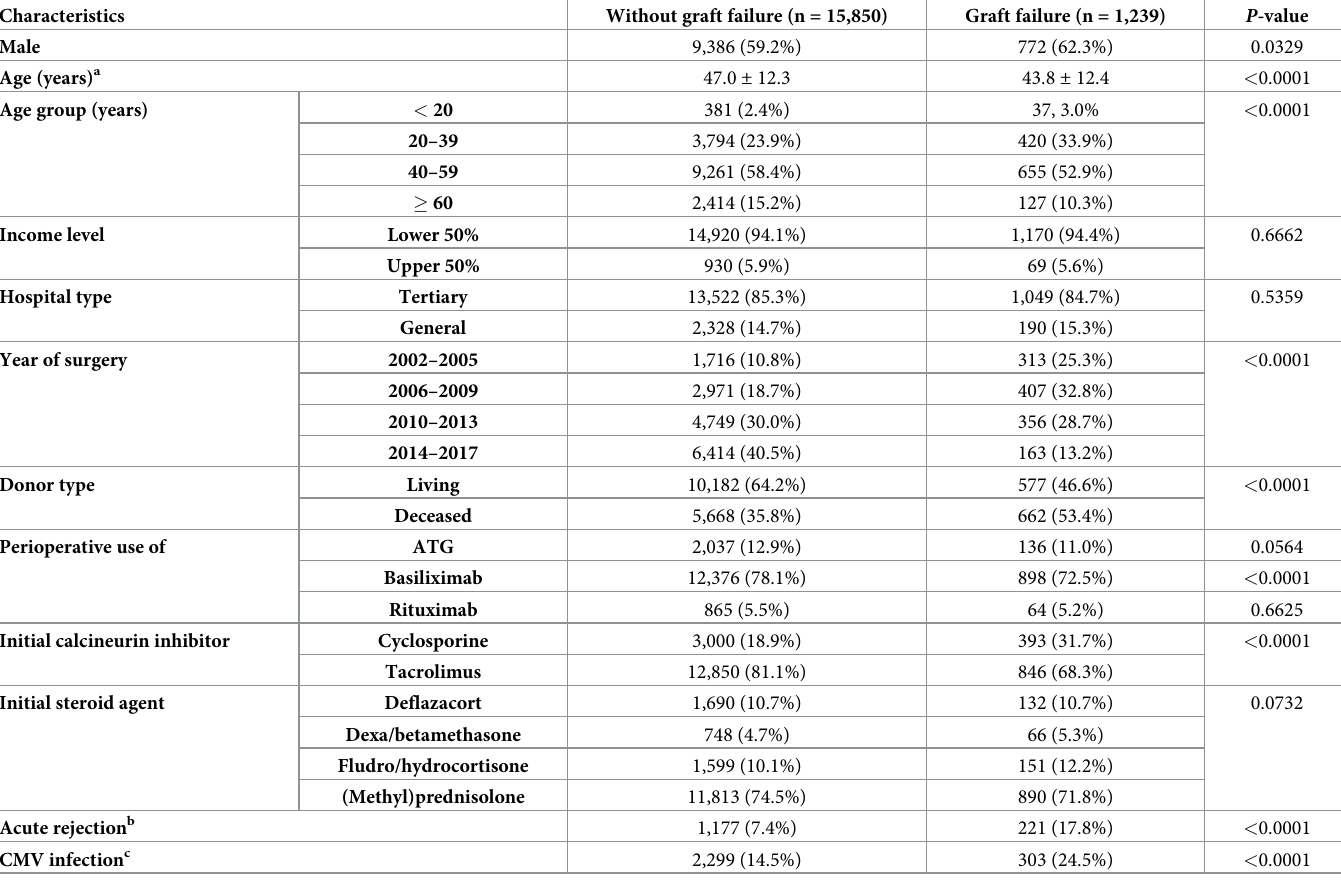
Table 4. Characteristics of patient according to the development of graft failure.